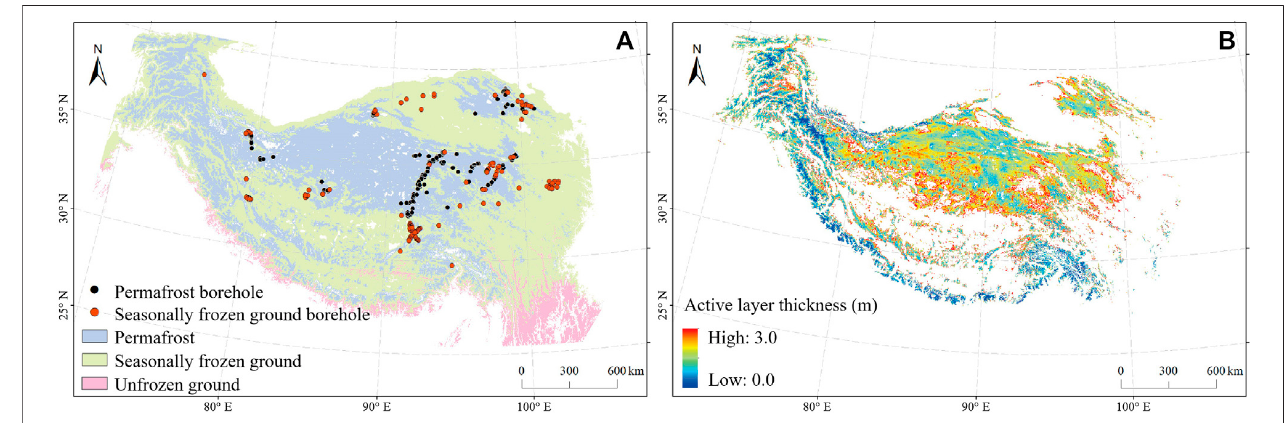
FIGURE 3 | Mean spatial patterns of permafrost distribution (A) and active layer thickness (B) over the Tibetan Plateau during the period of 2002 – 2016, simulated using a remote sensing driven hydrology model (Zheng et al., 2019b; Zheng et al., 2020). The satellite-based permafrost map indicates that permafrost and seasonally frozen ground account for ∼ 37% and ∼ 56% of the Tibetan Plateau respectively, with an overall accuracy of 79.3 – 90.7% in identifying permafrost boreholes and 76.5 – 86.4% in identifying seasonally frozen ground boreholes. The accuracy is generally higher than permafrost maps generated using ground-stations, which demonstrates the advantage of satellite remote sensing-based methods in simulating frozen soils in data-scarce